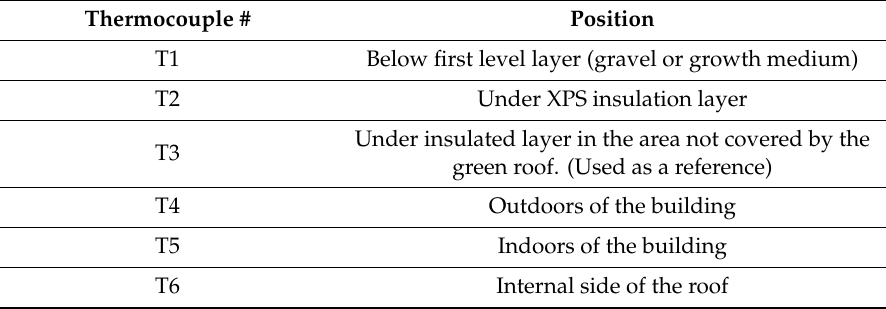
Figure 7. Monitoring system scheme.